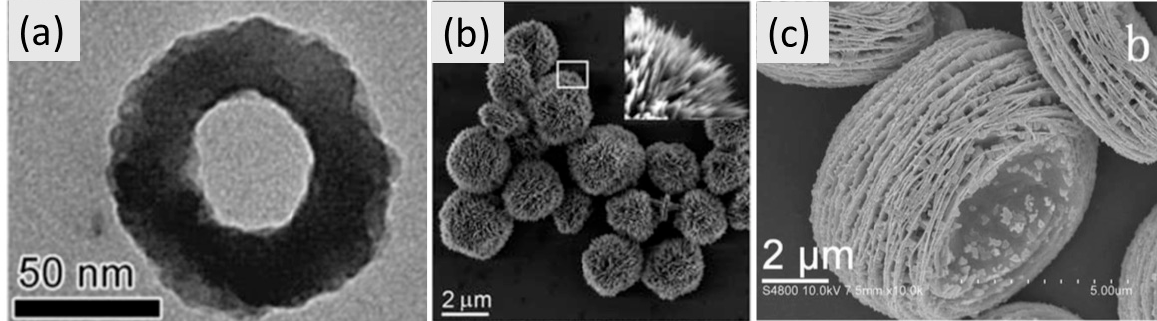
Figure 9. α -Fe 2 O 3 nanorings ( a ), CuO nanourchins ( b ), and lamellar Cd(OH) 2 ( c ) obtained by microwave-assisted hydrothermal method. Adapted from ref. [91]. Copyright © 2016, with permission from Elsevier.